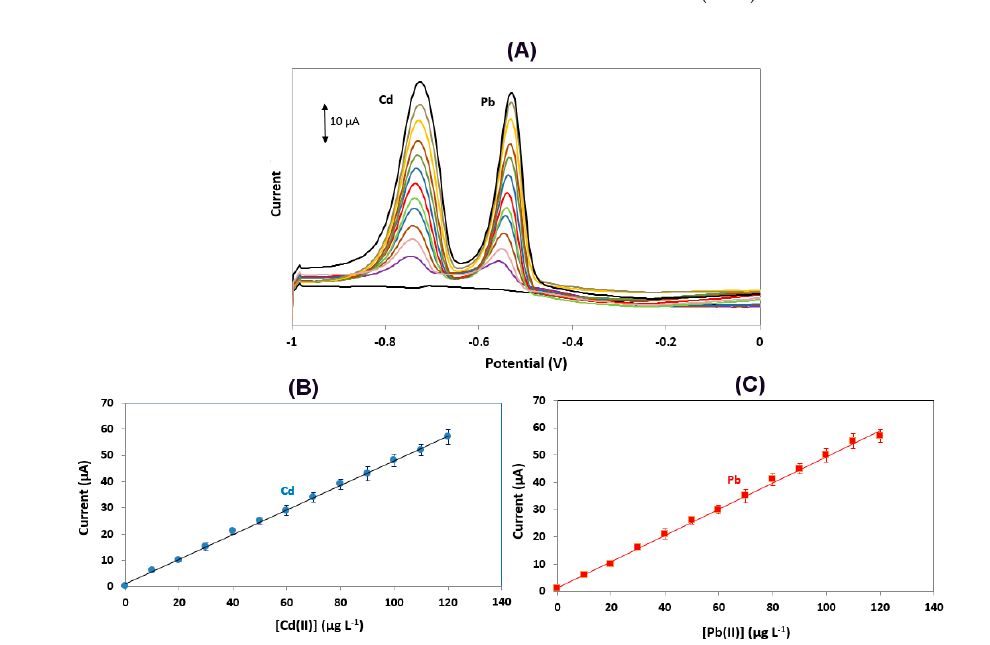
Figure 5. ( A ) Voltammograms for the determination of Pb(II) and Cd(II) in the range of 0–120 μ g L − 1 ; ( B ) calibration plot for Cd(II); ( C ) calibration plot for Pb(II). Conditions as in Figure